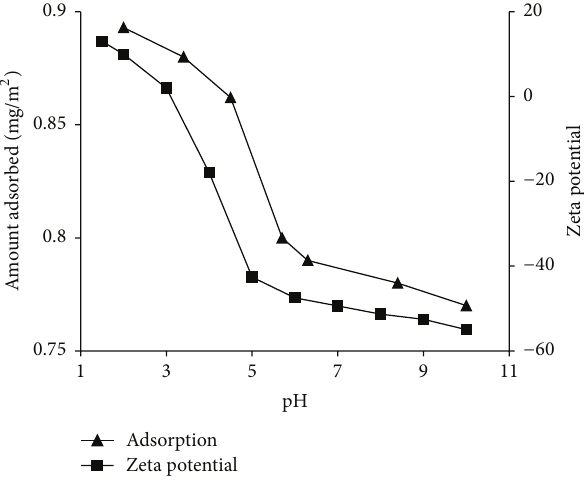
Figure 9: Amount of polymer adsorbed over silica as a function of pH. The error percentage was about 2.5 in adsorption and in case of zeta potential it was 5%.